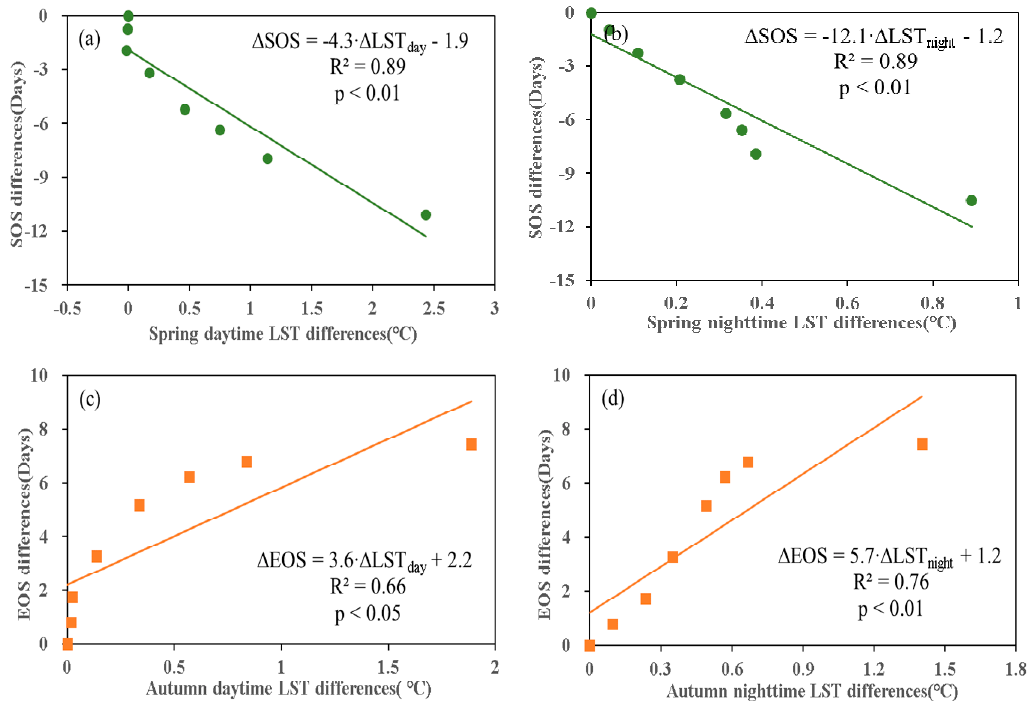
Figure 10. Linear regression relationships between the di ff erence of phenology and the di ff erence of LST at di ff erent time. ( a ) spring daytime LST di ff erence; ( b ) spring nighttime LST di ff erence; ( c ) autumn daytime LST di ff erence; ( d ) autumn nighttime LST di ff erence). The di ff erence in spring and autumn vegetation phenology calculated at di ff erent bu ff er distances from urban areas (y-axis) is linearly related to the di ff erence of LST across the same urban to rural gradient (x-axis). Each point represents a di ff erent bu ff er distance; the point at the origin is the rural endpoint, the point furthest from the origin is the urban